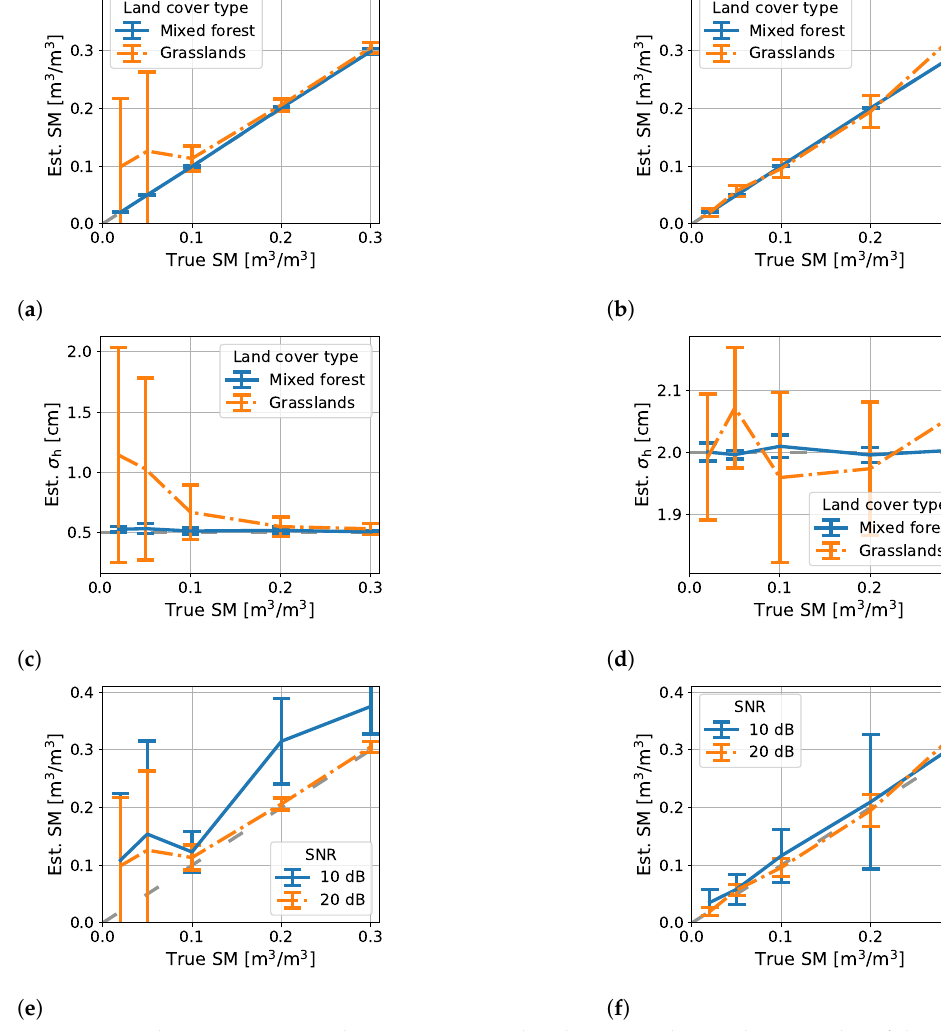
Figure 11. Soil moisture retrievals using two simulated DDMs. The incidence angles of the DDMs were 10° and 40°. The SNR was 20dB. The error bars represent one standard deviation from the mean, and the gray lines represent perfect retrievals. ( a ) σ h = 0.5cm, SNR = 20dB. ( b ) σ h = 2cm, SNR = 20dB. ( c ) σ h = 0.5cm, SNR = 20dB. ( d ) σ h = 2cm, SNR = 20dB. ( e ) Grassland land cover, σ h = 0.5cm. ( f ) Grassland land cover, σ h =